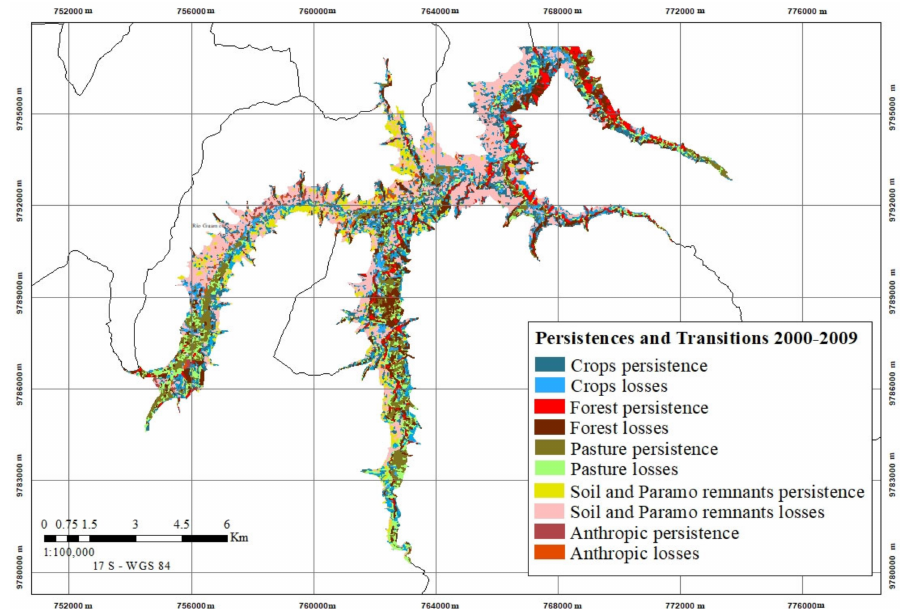
Figure 5. Map of coverage persistence and transitions between 2000 and 2009.